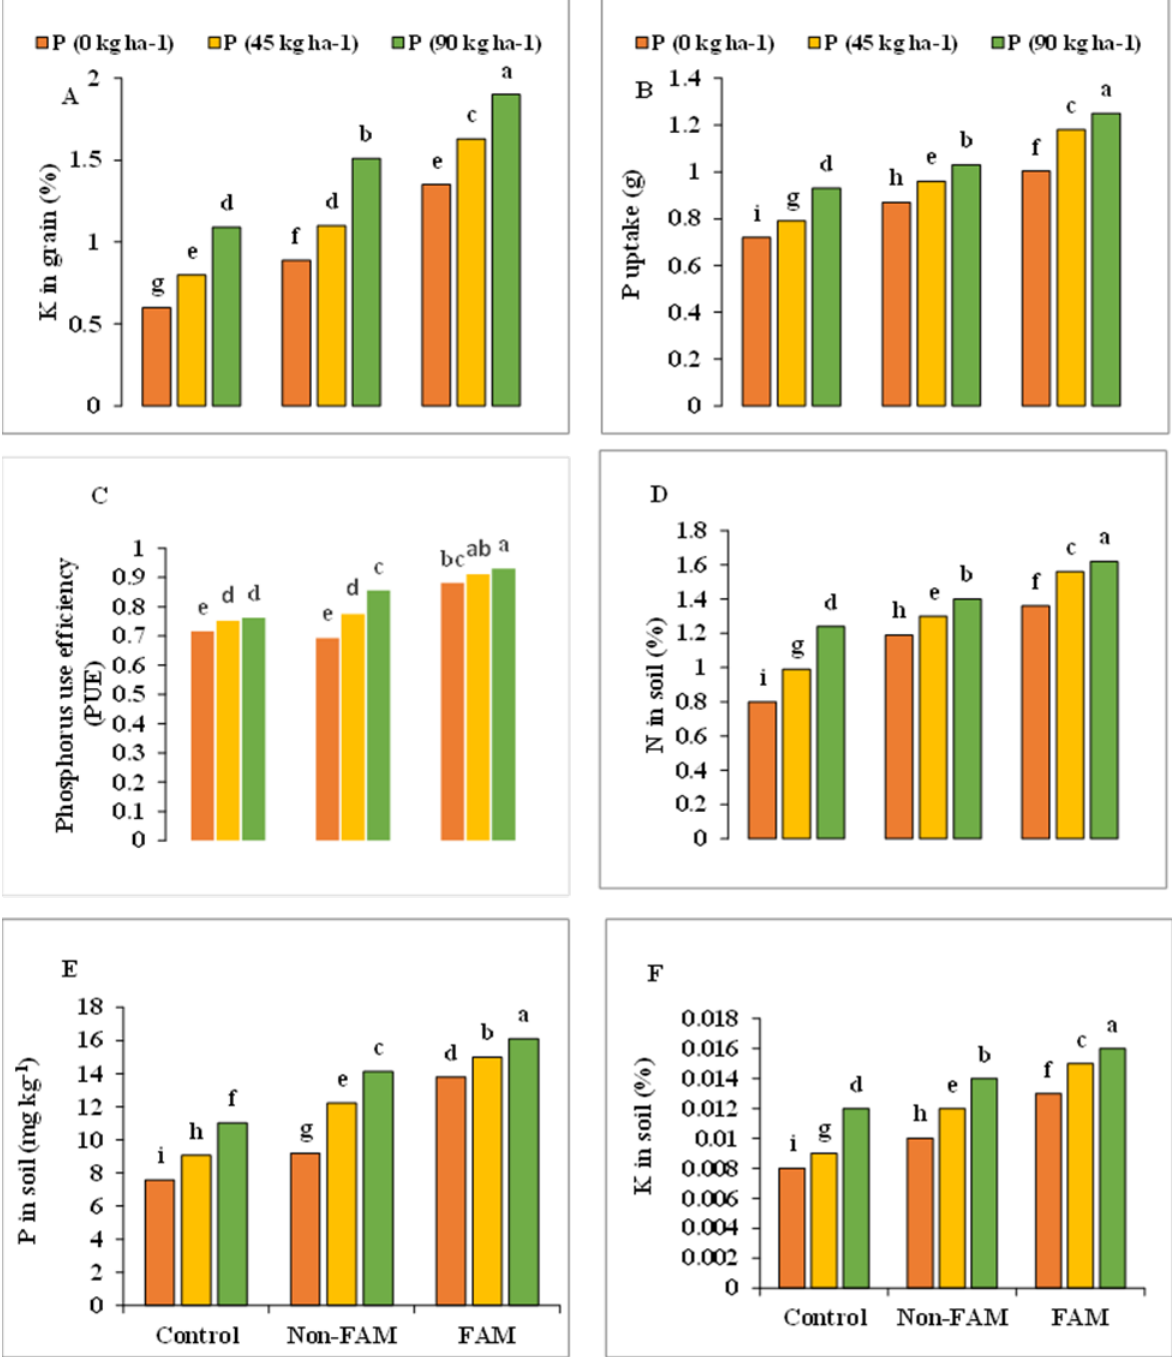
Figure 6. Combined use of fermented/non-fermented animal manure and phosphorus fertilizer on biochemical parameters of wheat. ( A ) K in grain, ( B ) P uptake, ( C ) P use efficiency, ( D – F ) NPK in soil. Columns with different letters are significantly different from one another at a level of significance of p < 5%.